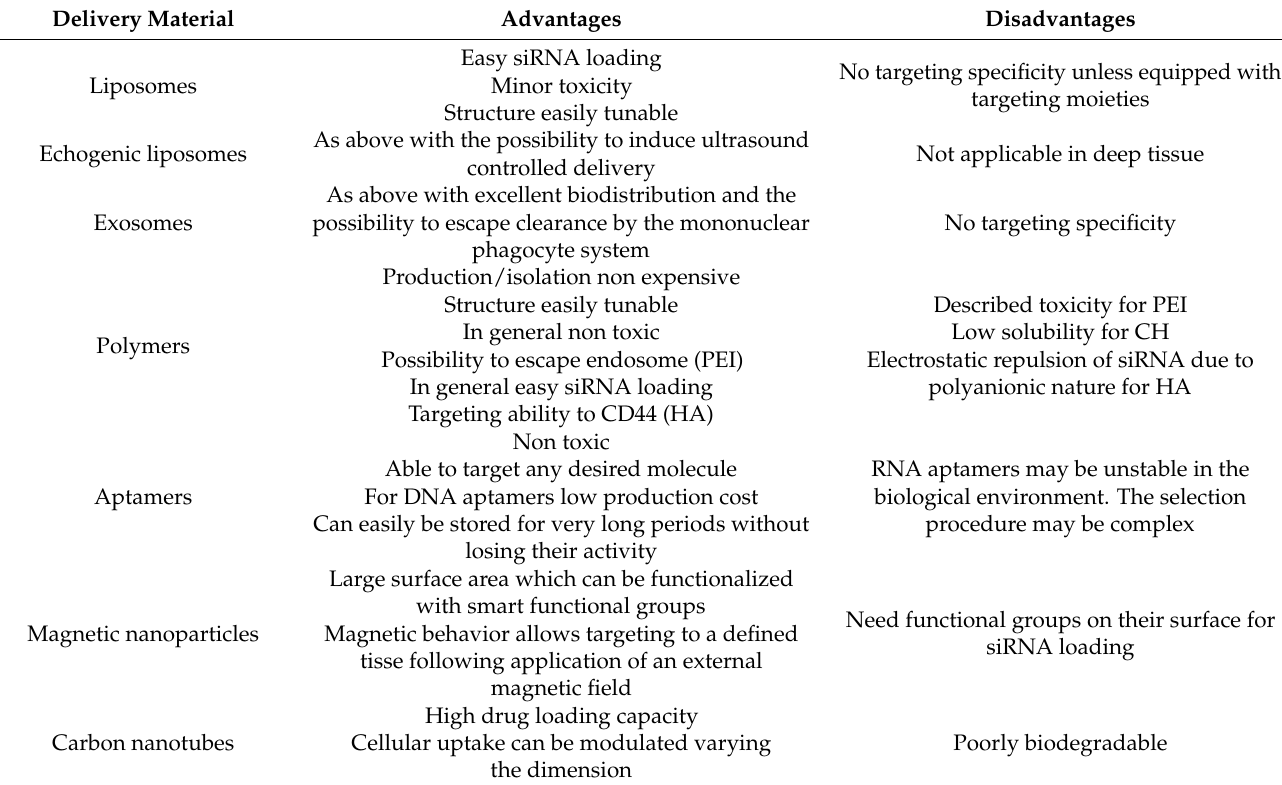
Table 1. Properties of siRNA delivery